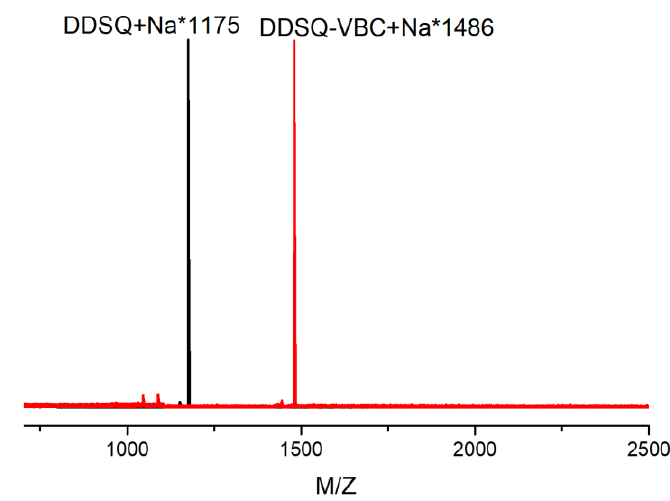
Figure 2. MALDI-TOF mass spectra of DDSQ and VBC-DDSQ-VBC.